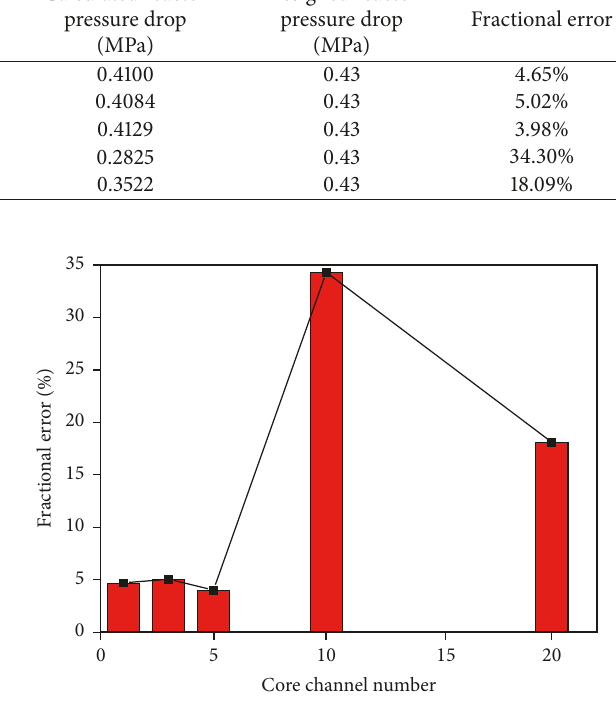
Figure 7: The influence of core channel number on the fractional error between calculated and designed reactor pressure drop. Table 5: Statistical results of reactor inlet